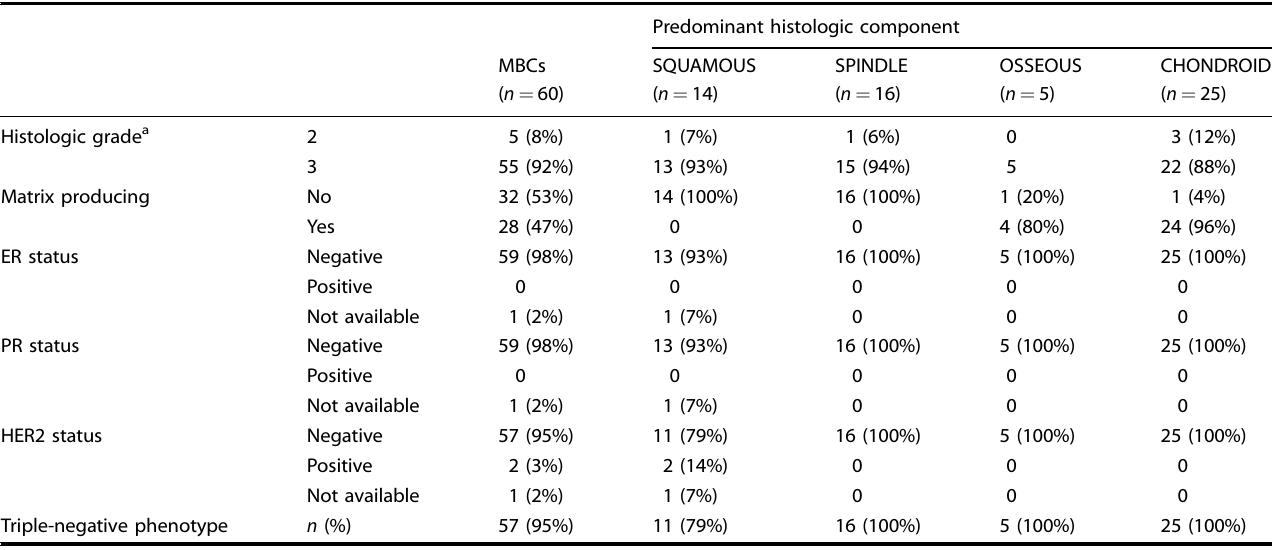
Table 1. Clinicopathologic features of 60 metaplastic breast carcinomas included in this